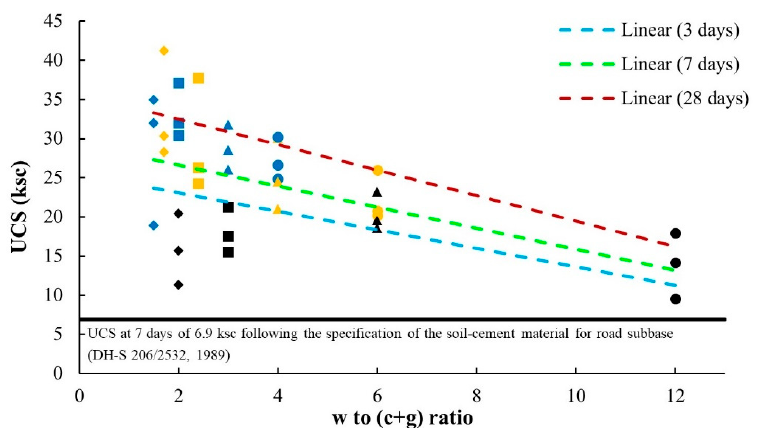
Figure 12. Unconfined compressive strength vs w/(c + g) ratio. Note : Line color: light blue, green, and dark red represent 3, 7, and 28 days, respectively. The color of shapes: dark, orange, and blue represents C1, C2, and C3, respectively. Shape: circle, triangle, square, and diamond represent G0, G1, G3, and G5, respectively.